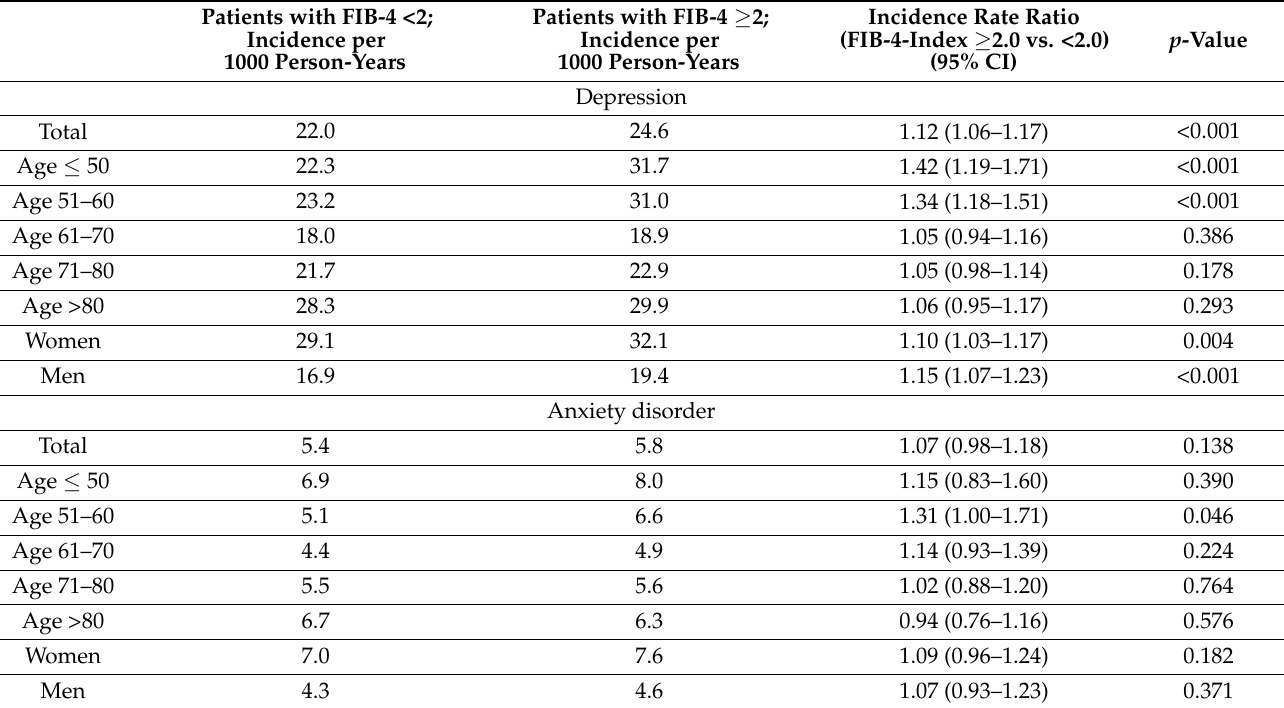
Table 3. Association between an FIB-4 index ≥ 2 and the incidence of depression and anxiety disorder within 10 years from the index date in patients followed in general practices in Germany stratified by age and sex (univariable Poisson regression